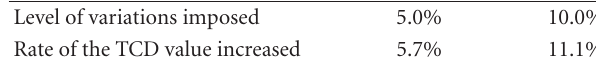
Table 2: E ff ect of increasing the degree of noise on the rate of the TCD value